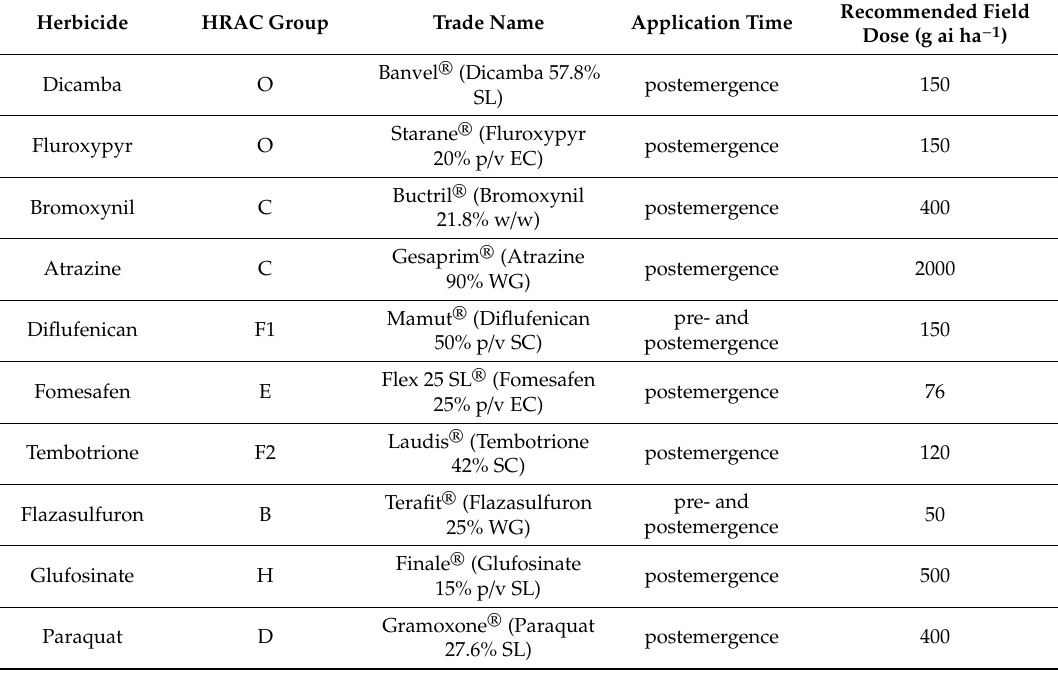
Table 1. Main characteristics of the herbicides used in the investigation of alternative chemical control in the